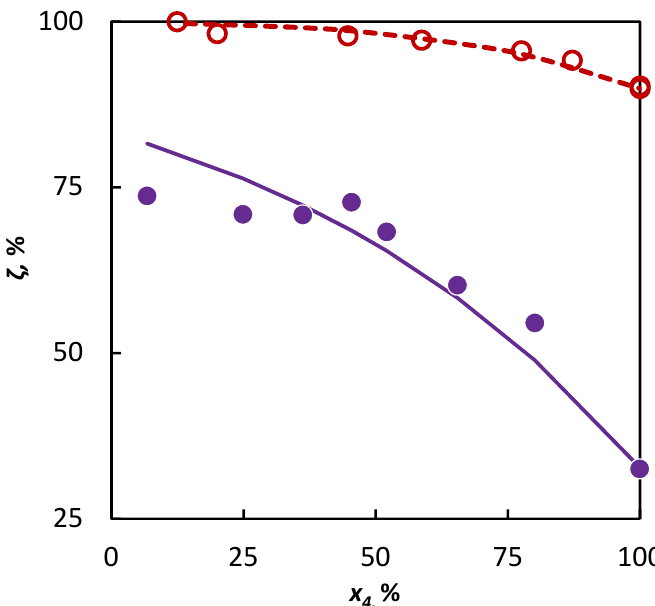
Figure 3. Co-pyrolysis of C4 hydrocarbons and 3-methylpentane: conversion of C4 hydrocarbons ( ○ 2-butene and ● isobutene) in dependence on their mole fraction in the binary mixture. Points repre- sent experimental data; solid line was obtained from regression analysis and dashed line is a simulation.